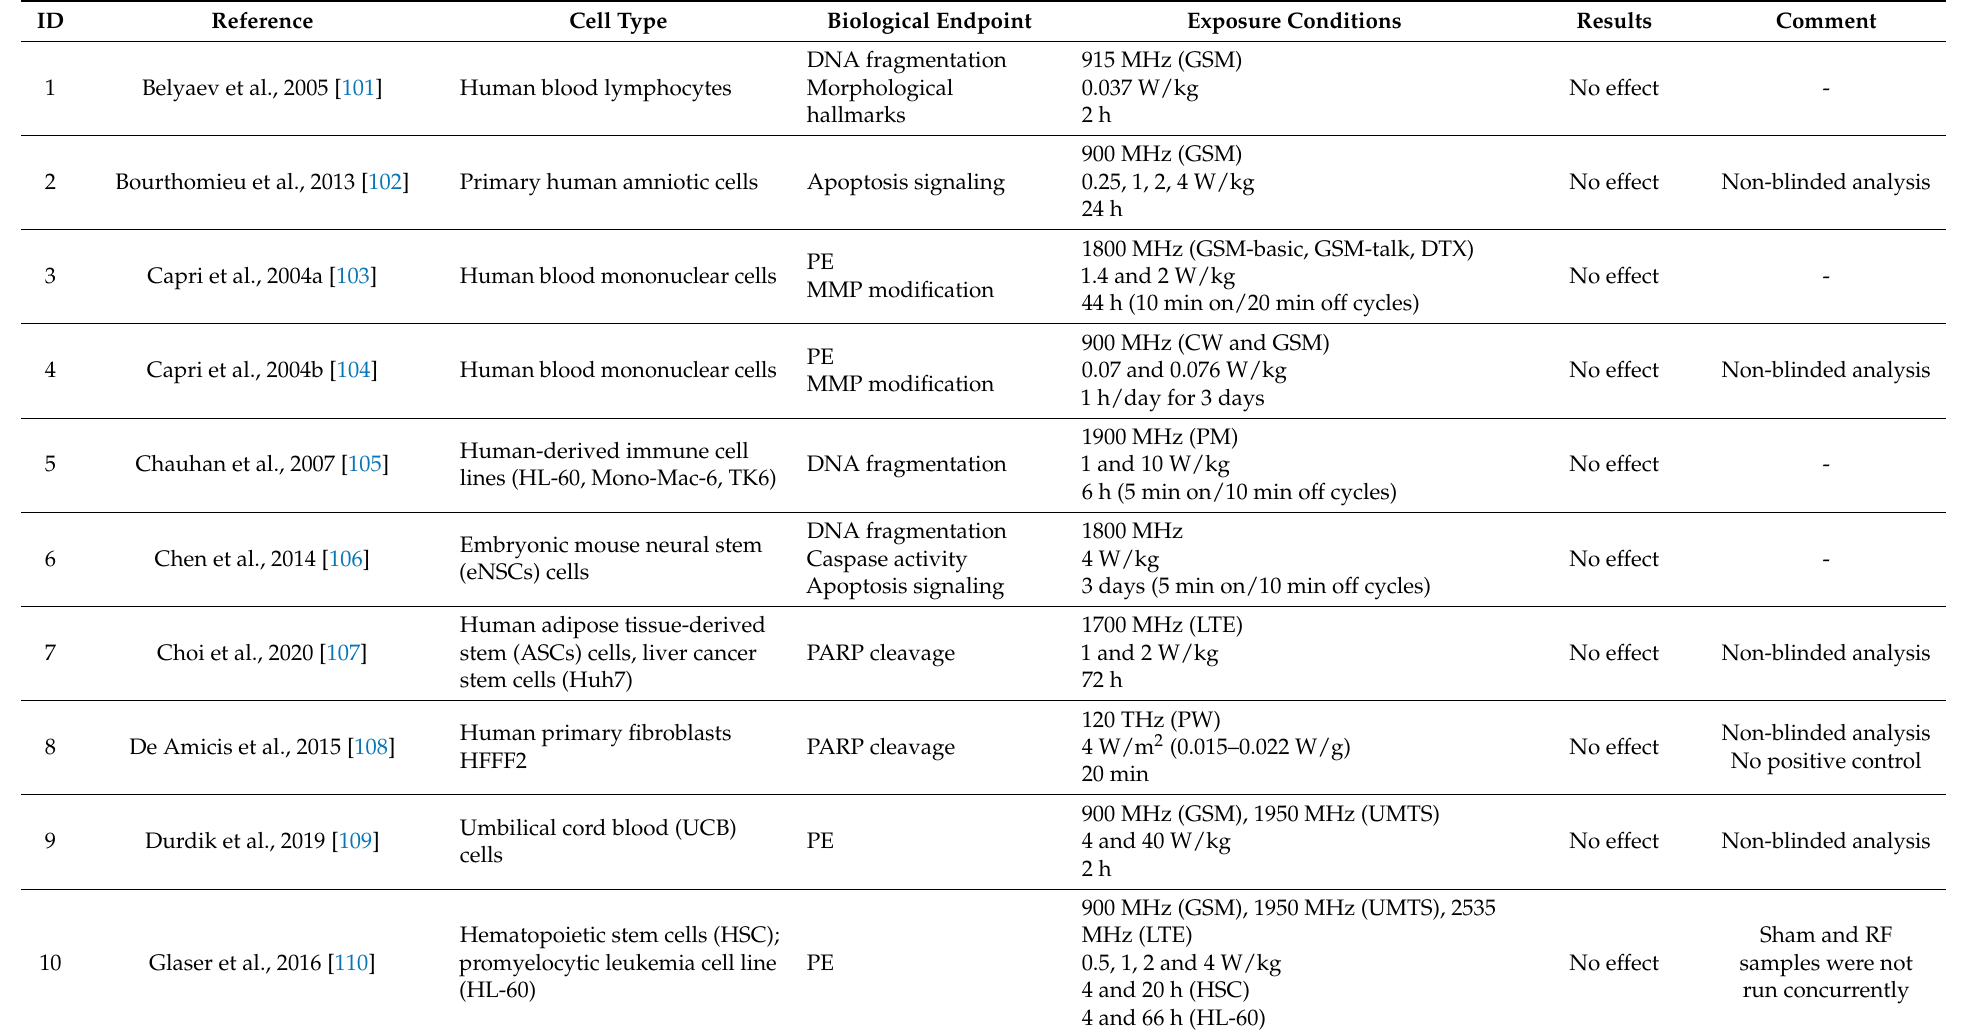
Table 3. Overview of studies that did not report statistically significant alterations of the apoptotic process following RF-EMF